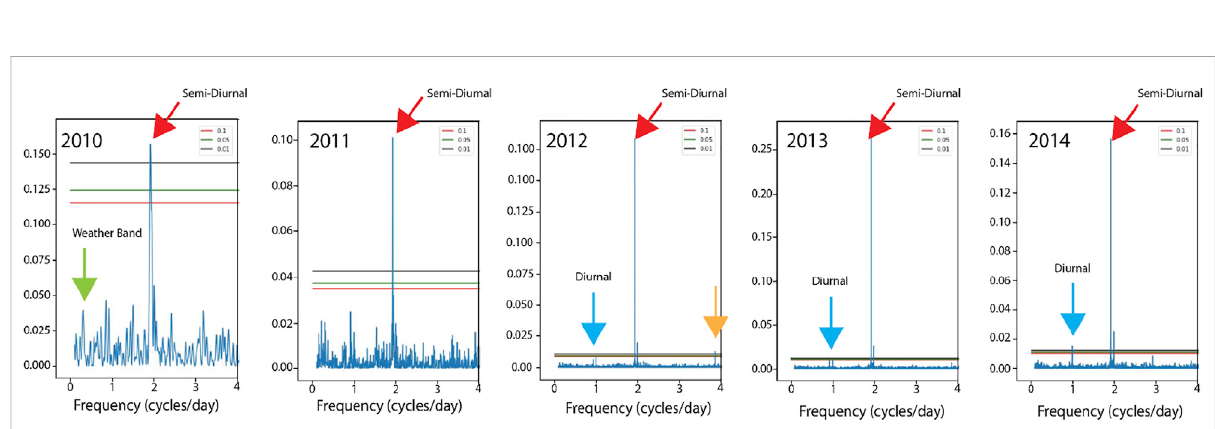
FIGURE 9 Lomb-Sparglespectraforall5 yearsshowdominantperiodicityonlyinthesemi-diurnalcycle(withoccasionalsigni fi cantpeaksinthediurnalor quarter diurnal ranges). Higher false alarm probability levels in years 2010 and 2011 re fl ect the shorter duration and more limited data from those years. Primary signi fi cant peaks are the semi-diurnal (red arrow) and diurnal (blue arrow); the only other signi fi cant peak (orange arrow) could be either aliasing as Nyquist frequency only approximate for irregular sampling or alternatively the upper harmonics of the diurnal frequency related to re fl ections about bathymetric obstacles.